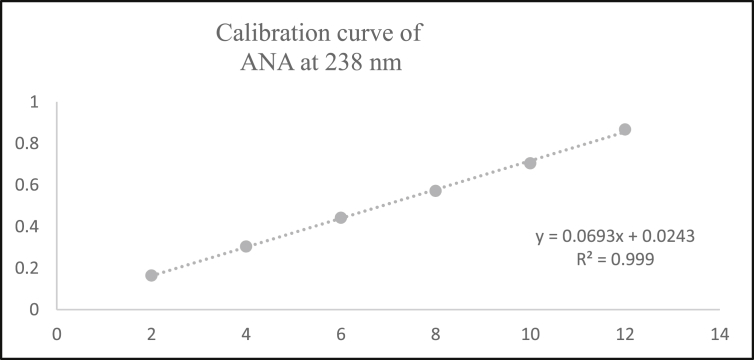
Calibration curve of ANA at λ1 = 238 nm.